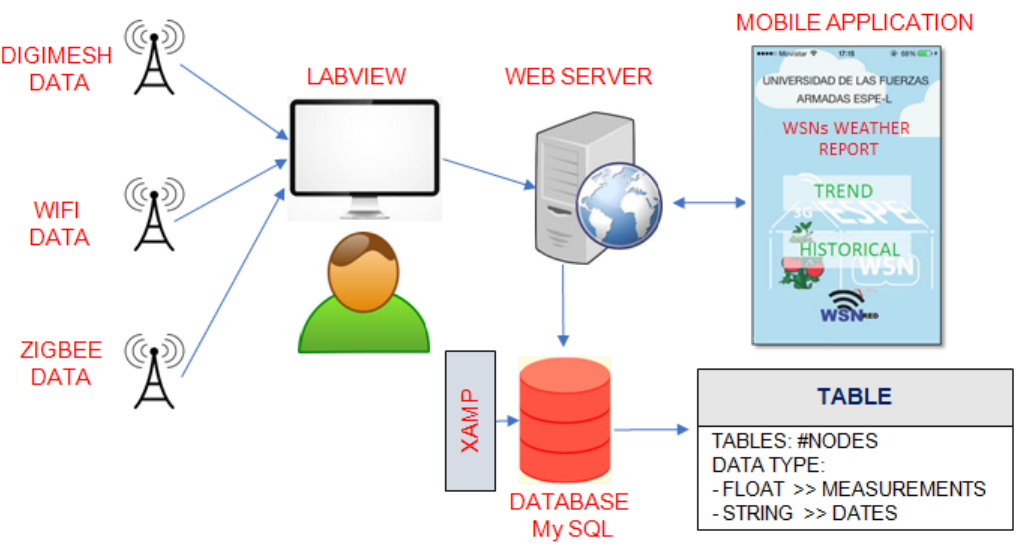
Figure 6. Mobile application development.